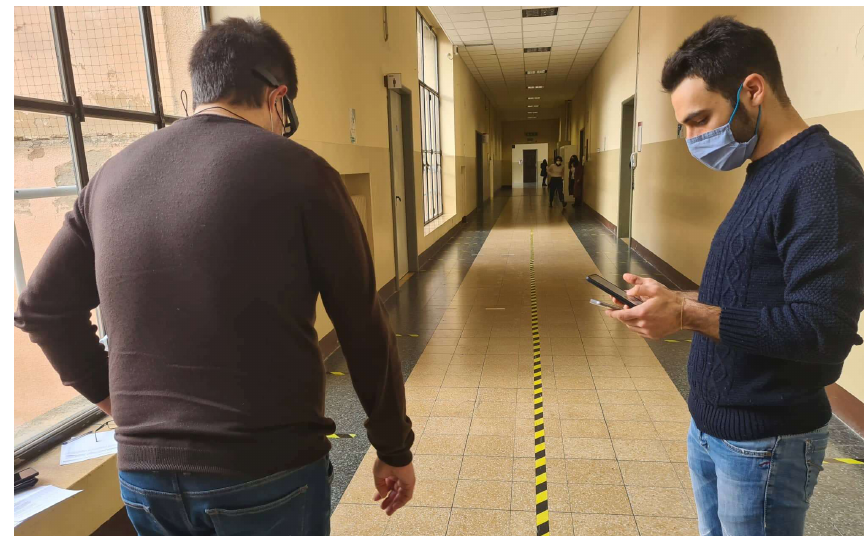
Figure 1. A user walks along the selected path while receiving a sensory cue.